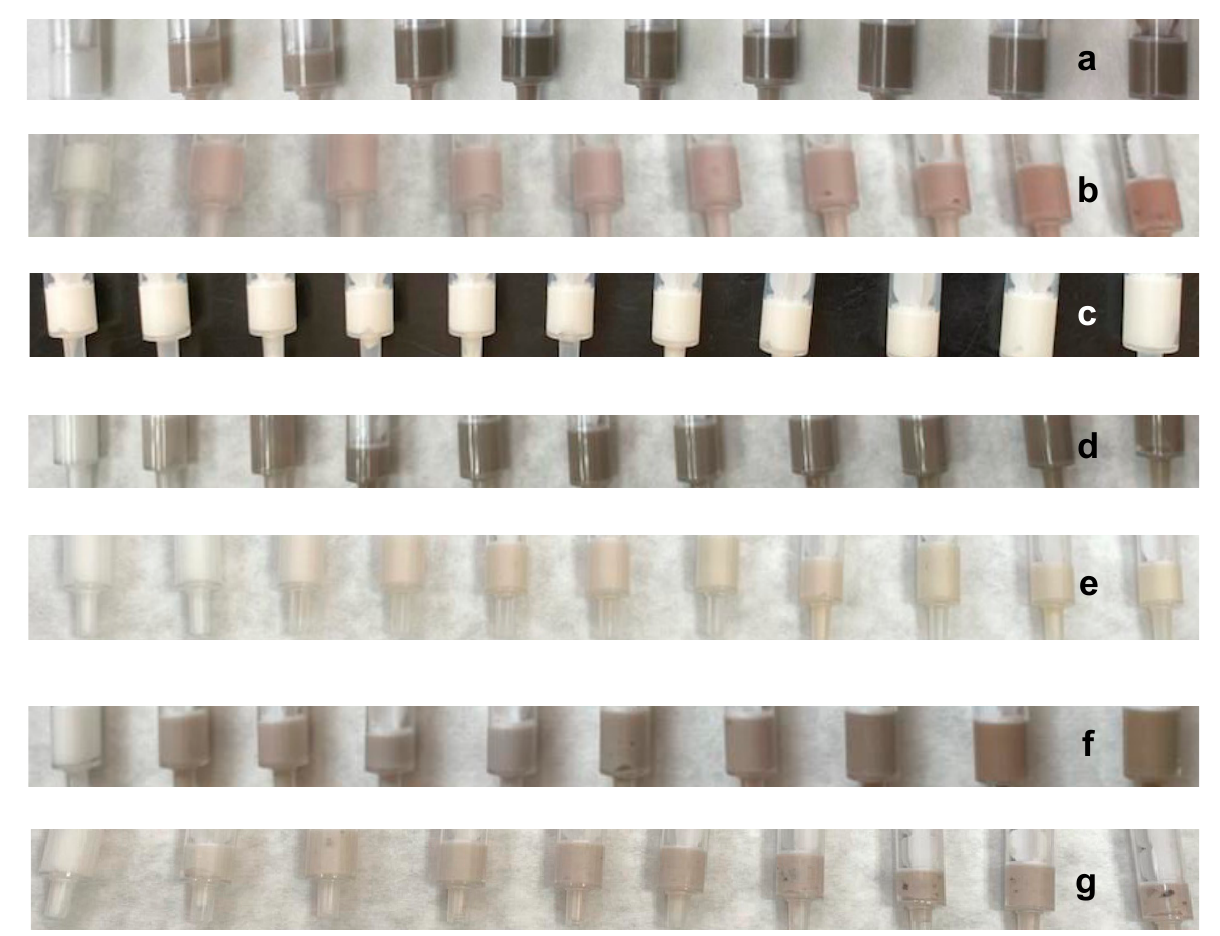
Figure 6. Body creams (1.0 g) prepared with ( a ) AgNPs (blank, 0.1, 0.2, 0.3, 0.4, 0.5, 0.6, 0.7, 0.8 and 0.9 mg), ( b ) PCE (blank, 0.1, 0.2, 0.3, 0.4, 0.5, 0.6, 0.7, 0.8 and 0.9 mg), ( c ) PCE after two days from addition, ( d ) AgNPs/PCE (blank, 0.1/1.0, 0.2/2.0, 0.3/3.0, 0.4/4.0, 0.5/5.0, 0.6/6.0, 0.7/7.0, 0.8/8.0, 0.9/9.0 and 1.0/10.0 mg), ( e ) PCE encapsulated in β CD (blank, 1.0, 2.0, 3.0, 4.0, 5.0, 6.0, 7.0, 8.0, 9.0 and 10.0 mg), ( f ) AgNPs and PCE encapsulated in β CD (blank, 0.1/1.0, 0.2/2.0, 0.3/3.0, 0.4/4.0, 0.5/5.0, 0.6/6.0, 0.7/7.0, 0.8/8.0 and 0.9/9.0 mg), and ( g ) PCE encapsulated in p NIPAM (blank, 1.0, 2.0, 3.0, 4.0, 5.0, 6.0, 7.0, 8.0, 9.0 and 10.0 mg). All images show increased concentration from left to right.